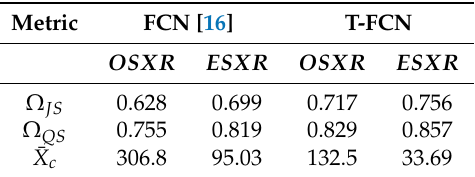
Table 6. Performance comparisons between the prior and proposed D-CNN-based methods on different test